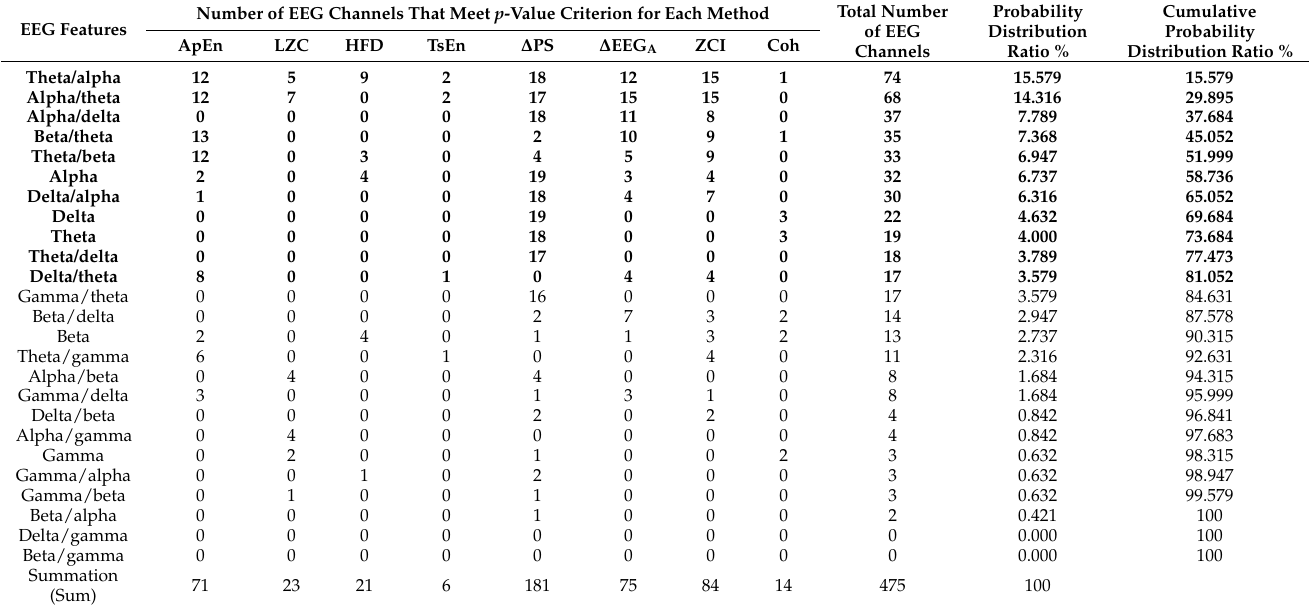
Table 3. Probability distribution ratio for all 25 EEG features for each